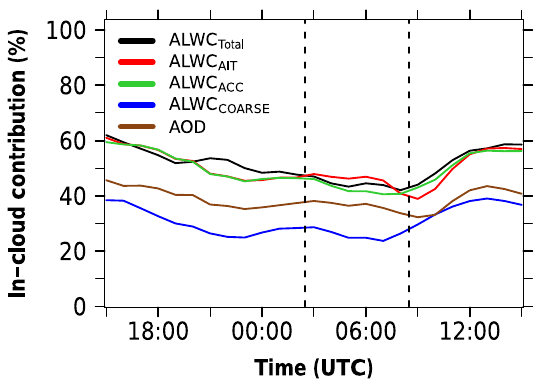
Figure 8. Diurnal cycle of the median contribution from in-cloud areas (%) with respect to ALWC Total (black), ALWC AIT (red), ALWC ACC (green), ALWC COARSE (blue) and the contribution of in-cloud AOD to the total AOD (brown) in the total vertical column over the Ivory Coast (7.5–3 ◦ W, 4–10 ◦ N) from 2 July 15:00UTC to 3 July 15:00UTC. The vertical dashed lines denote the three phases introduced in Fig.